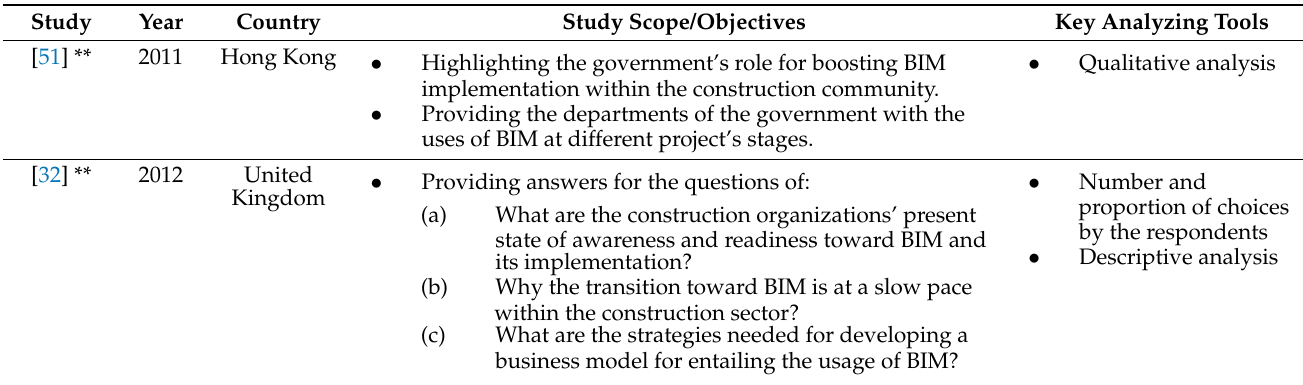
Table A1. Analyzing the literature of the KSFs of BIM